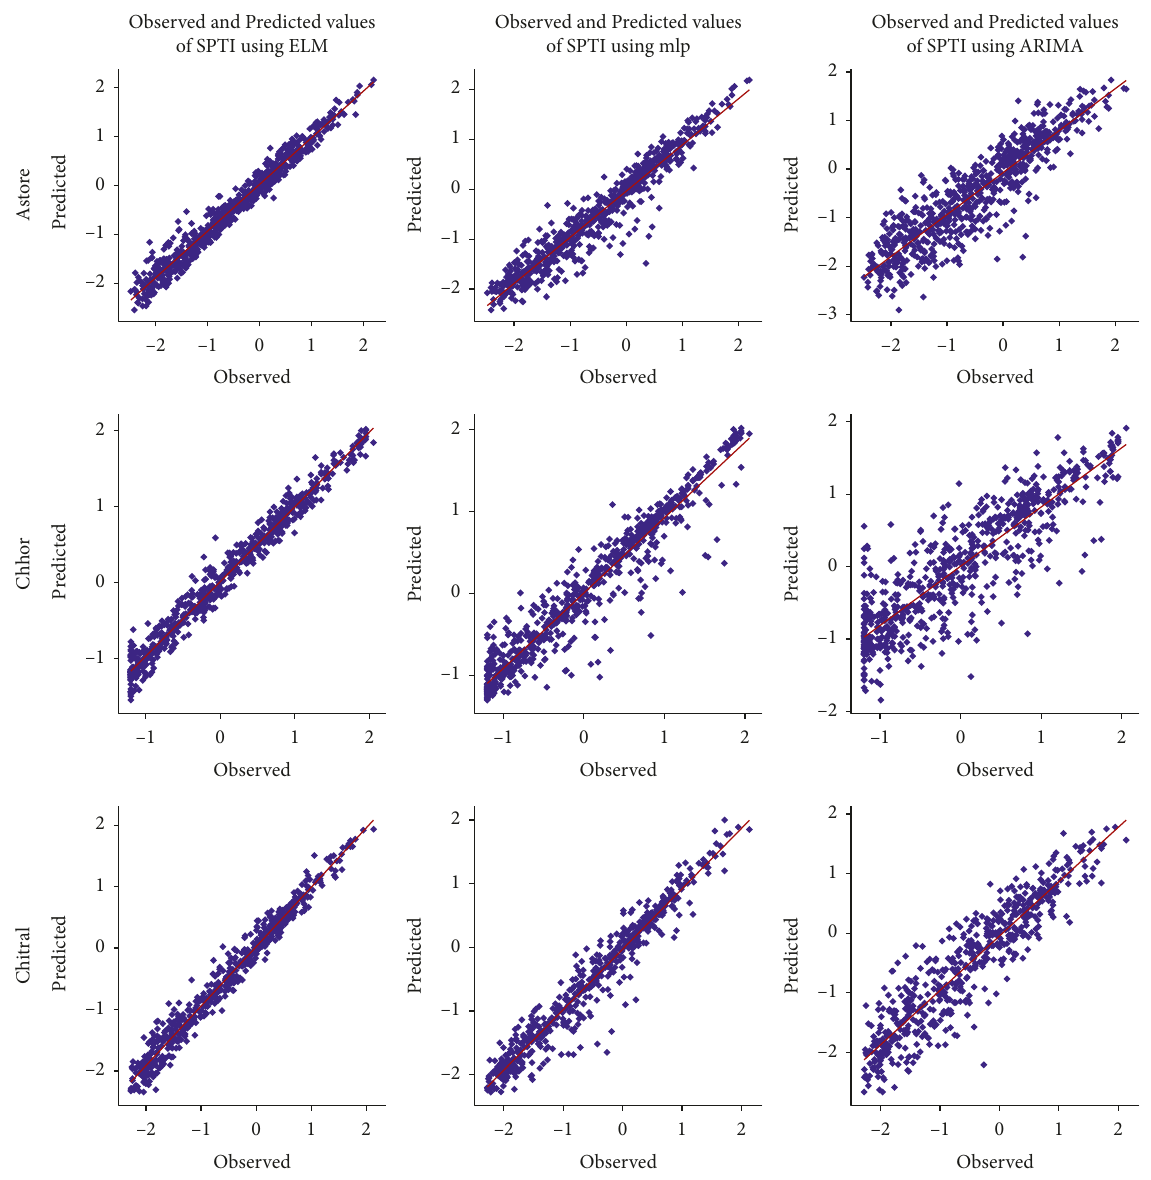
Figure 8: Scatter plots of the observed and predicted values of SPTI-6 using ELM, MLP, and ARIMA at Astore, Chhor, and Chitral stations for the training